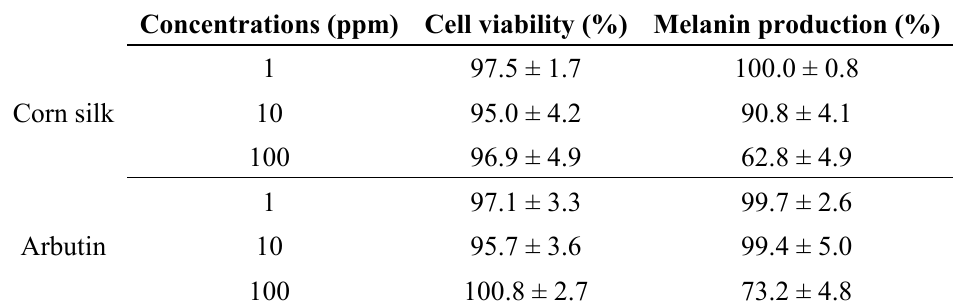
Table 1. Effects on cell viability and melanin production in Melan-A